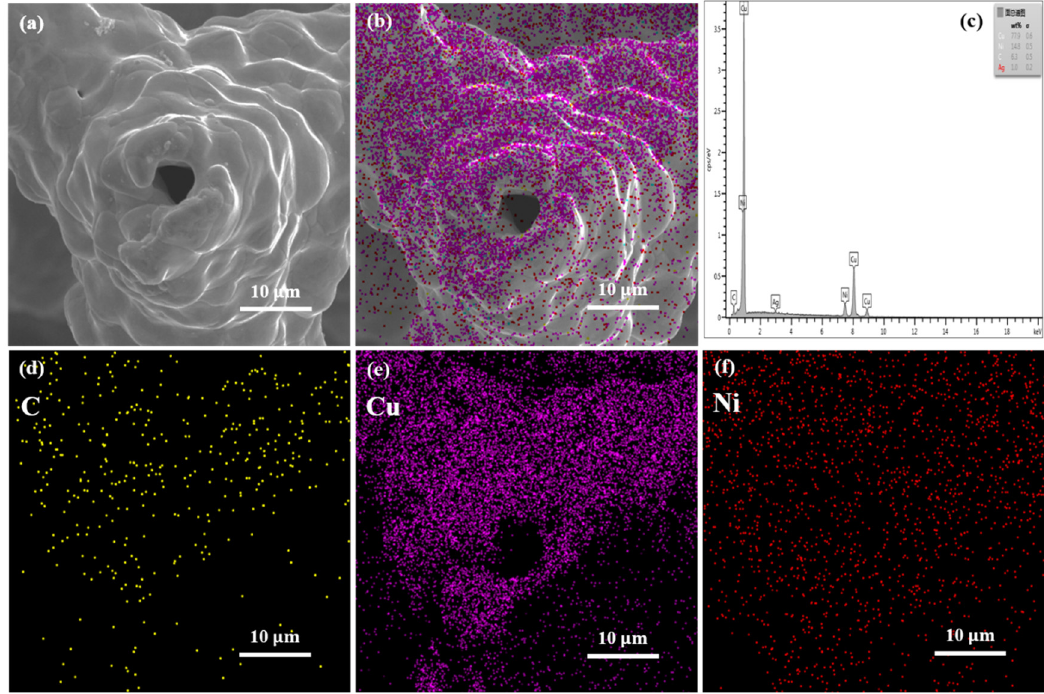
Figure 4. The cross section of Cu-Ni/CNTs foams after heat treatment; ( a ) SEM observation; ( b – f ) EDS analysis of the cross section.